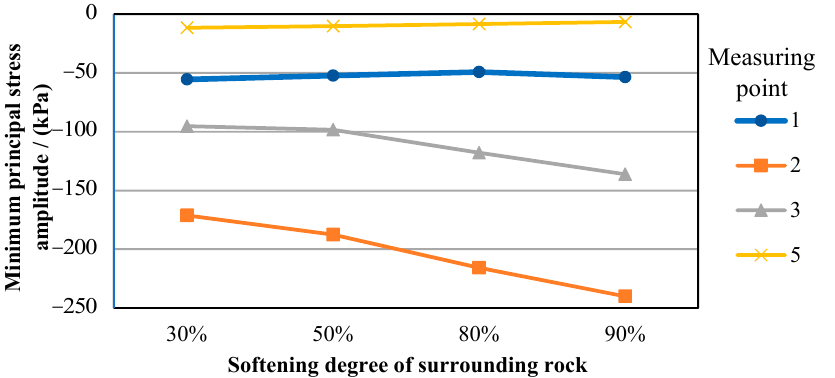
Figure 15. Minimum principal stress increment amplitude diagram of measuring points 1, 2, 3, and 5 under different softening degrees of basement surrounding rock.